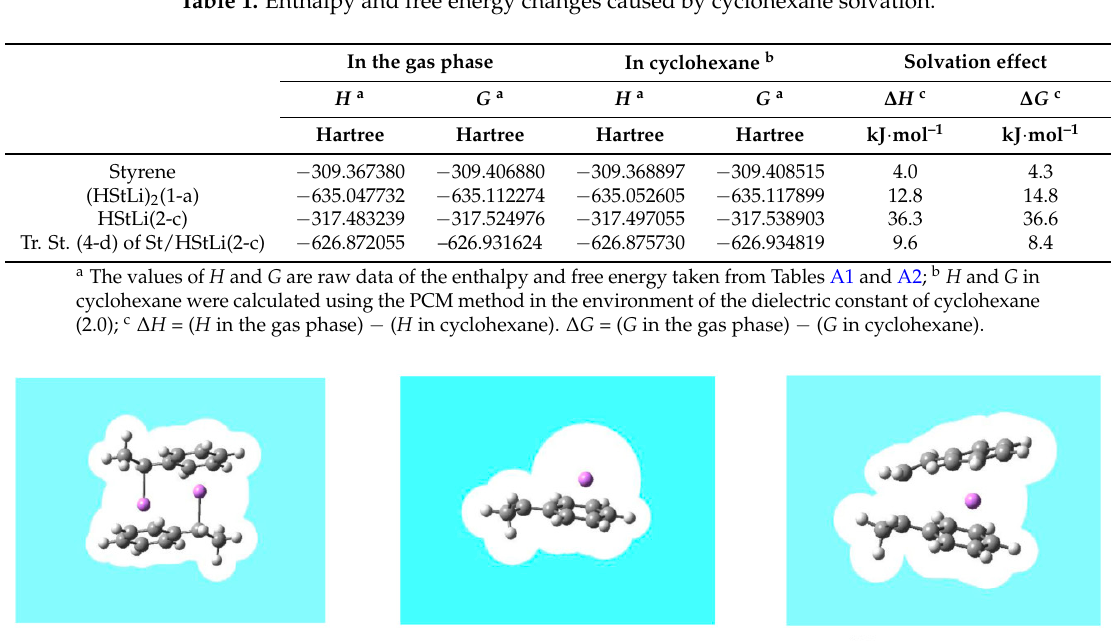
Table 1. Enthalpy and free energy changes caused by cyclohexane solvation.